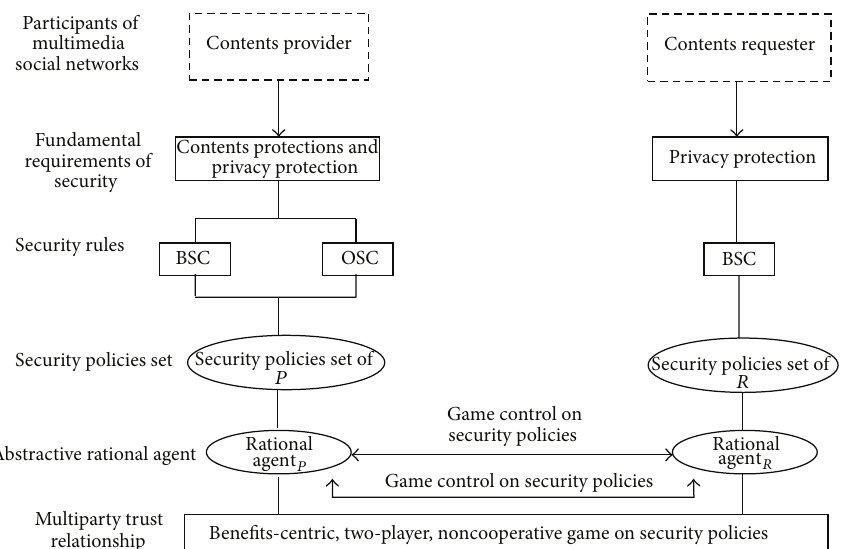
Figure 1: Two-party trust architecture in multimedia social